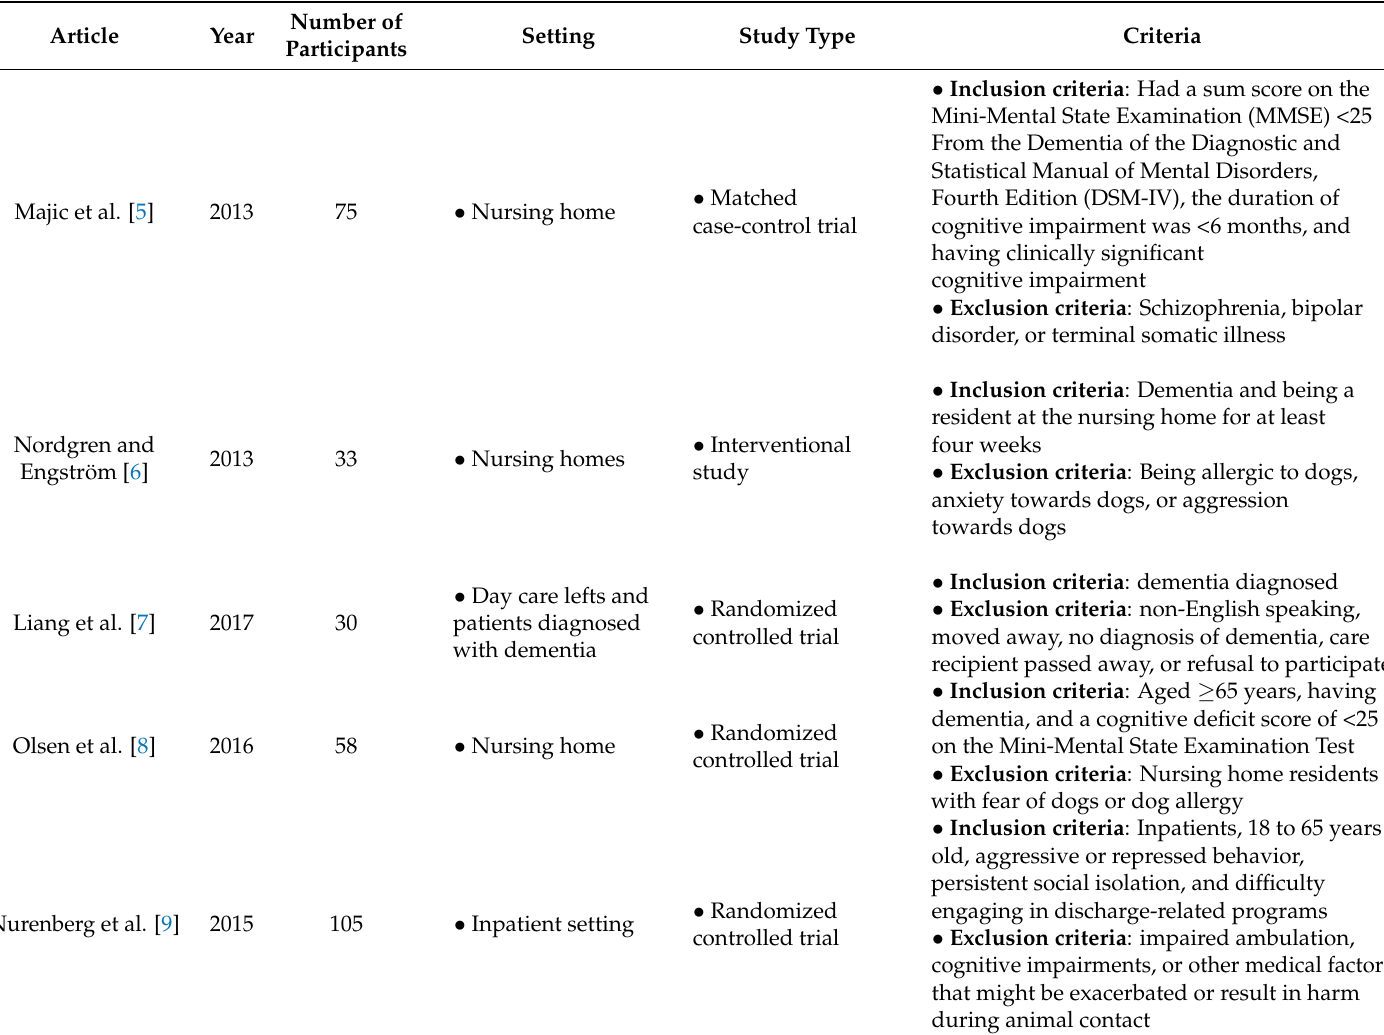
Table 1. Summary of all of the studies